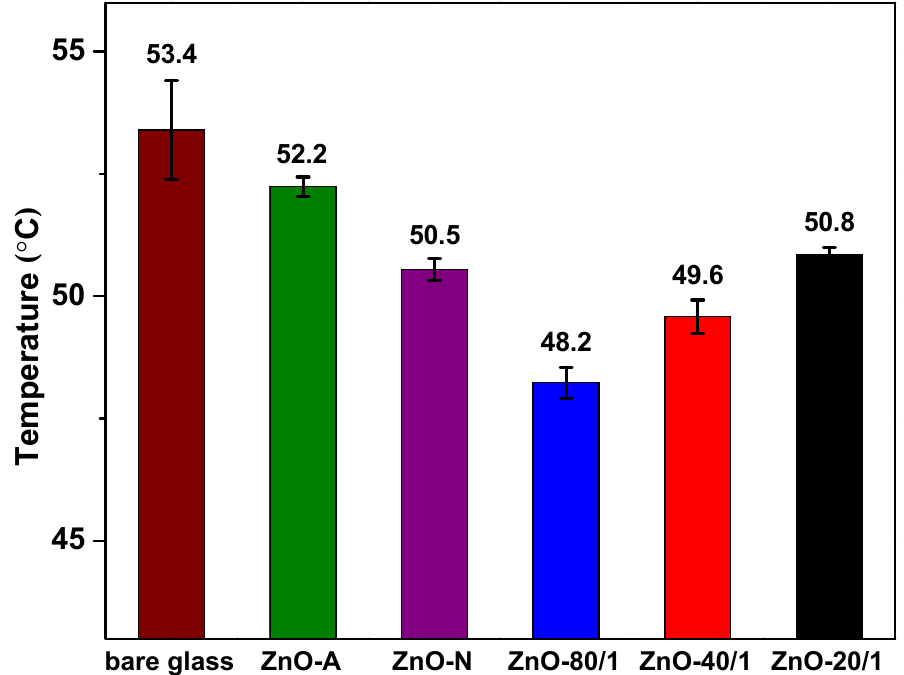
Figure 8. The thermal insulation test of ZnO prepared from different ratios of ZA/ZN precursors. The surrounding temperature was 70 ± 2 °C.